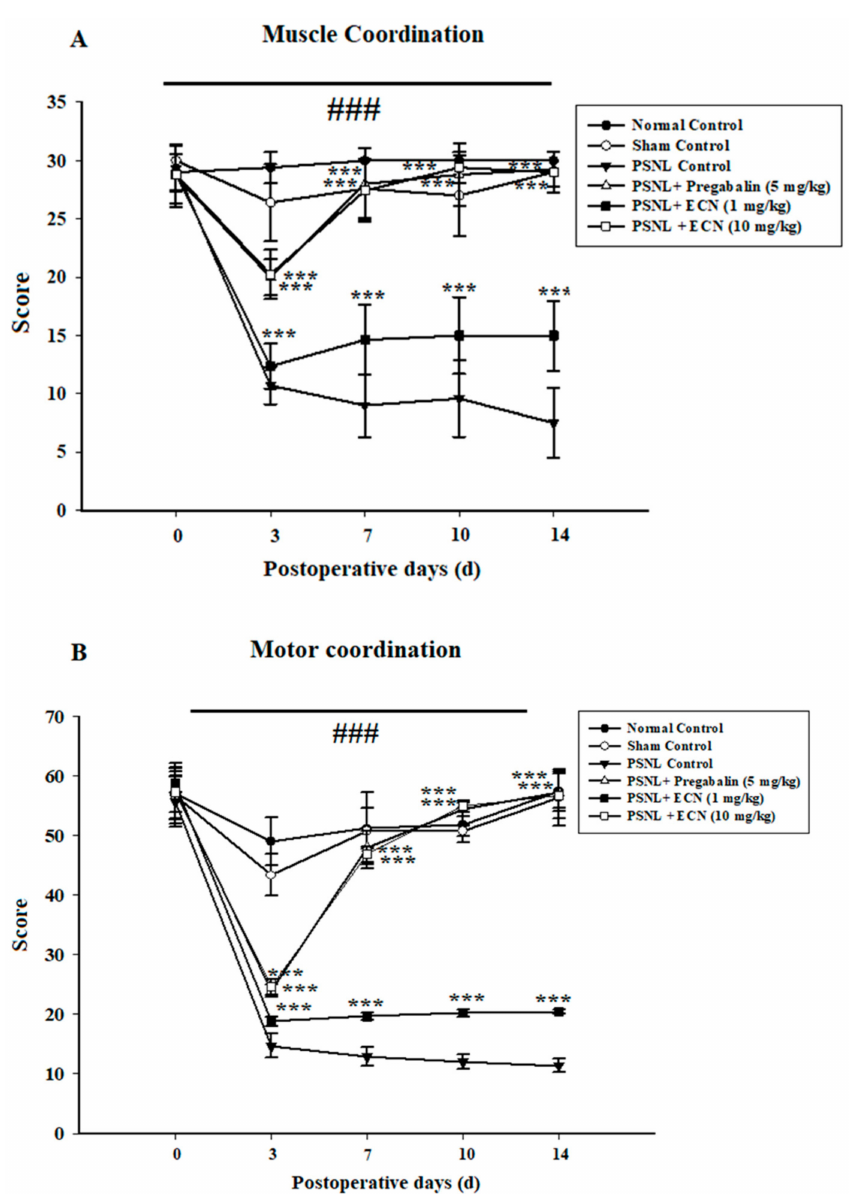
Figure 3. Effect of ECN (1 and 10 mg/kg i.p.) on PSNL-induced muscle activity by ( A ) Muscle coordination ( B ) Motor coordination. The effect on muscle coordination and motor coordination was measured at 0, 3, 7, 10 and 14 day after PSNL. The data were reported as the means S.D; (n = 5 mice per group) of scoring average. Different letters meant statistically significant differences: (***) p < 0.001 indicate significant differences from the PSNL control group. (###) indicate significant differences from the normal control group. *** p < 0.001 (two-way ANOVA followed by Dunnett’s